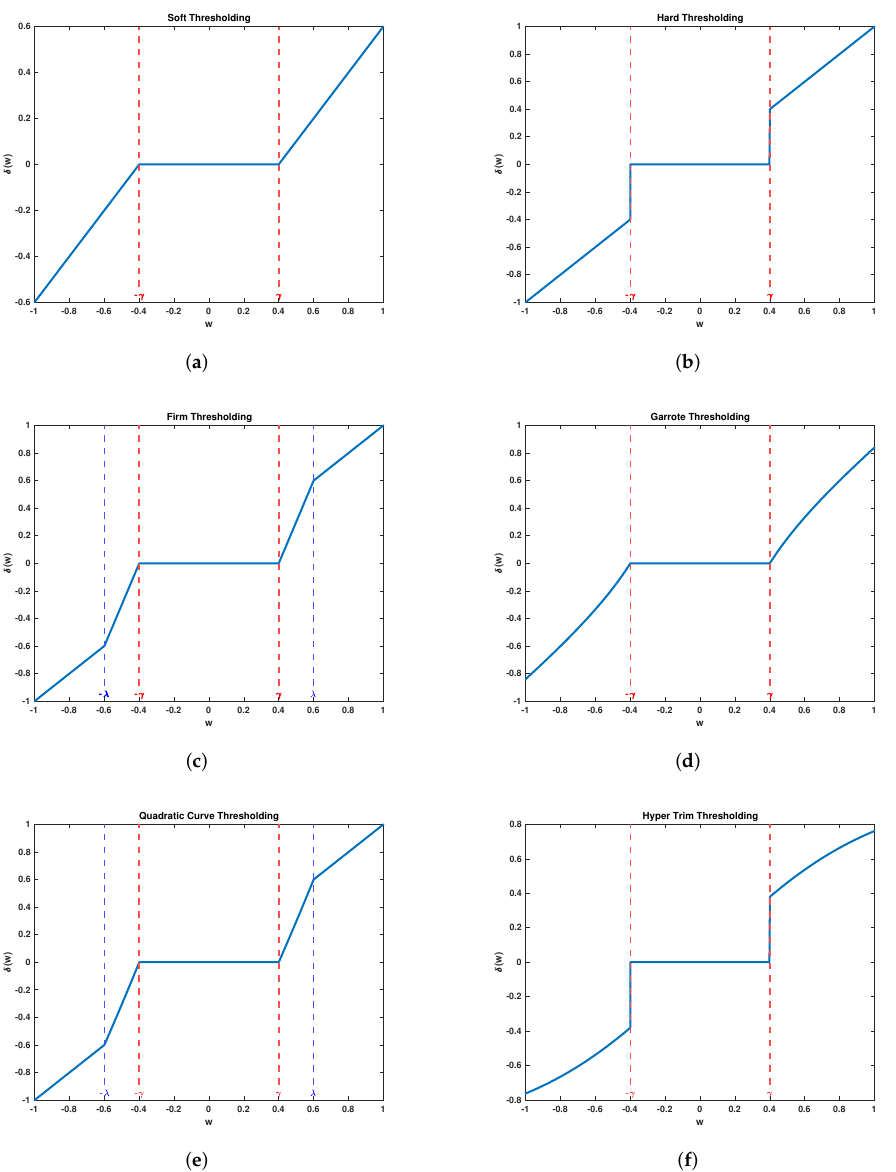
Figure 3. Graphical representation of thresholding methods ( a ) − soft thresholding, ( b ) − hard thresholding, ( c ) − firm thresholding, ( d ) − Garrote thresholding, ( e ) − quadratic curve thresholding, ( f ) − hyper-trim